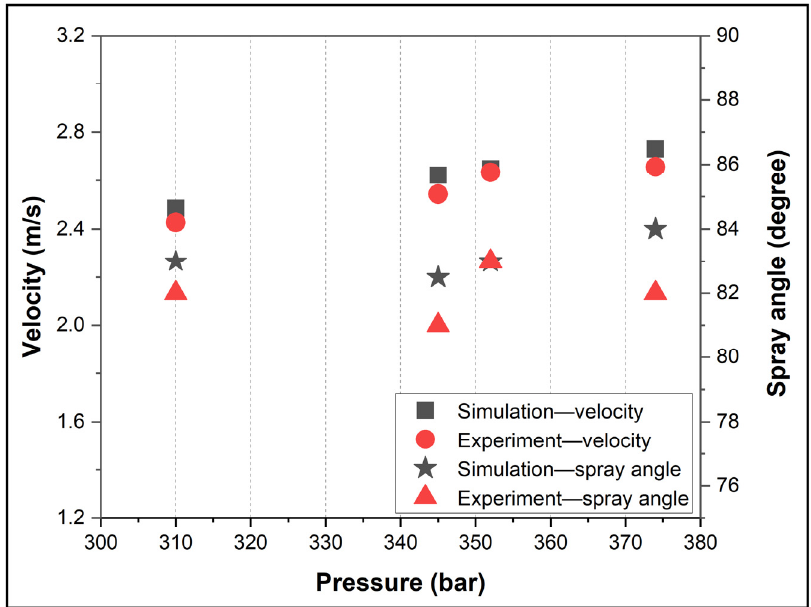
Figure 6. Comparison of experimental and simulation results.